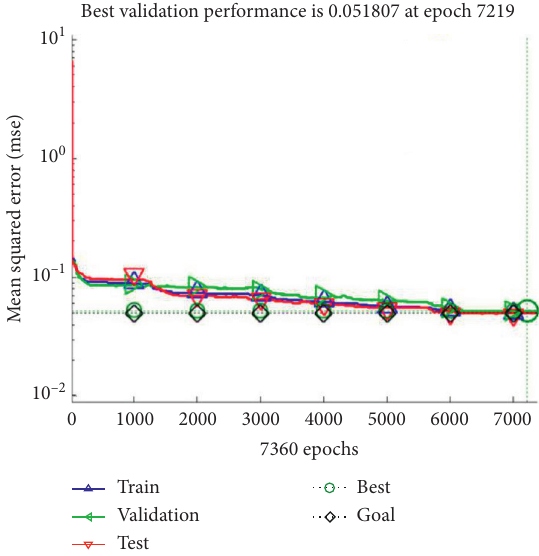
Figure 4: The training error curve of FB network.